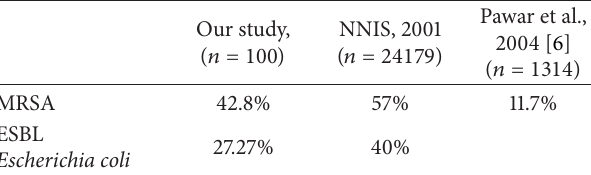
Table 6: Comparison of MDR